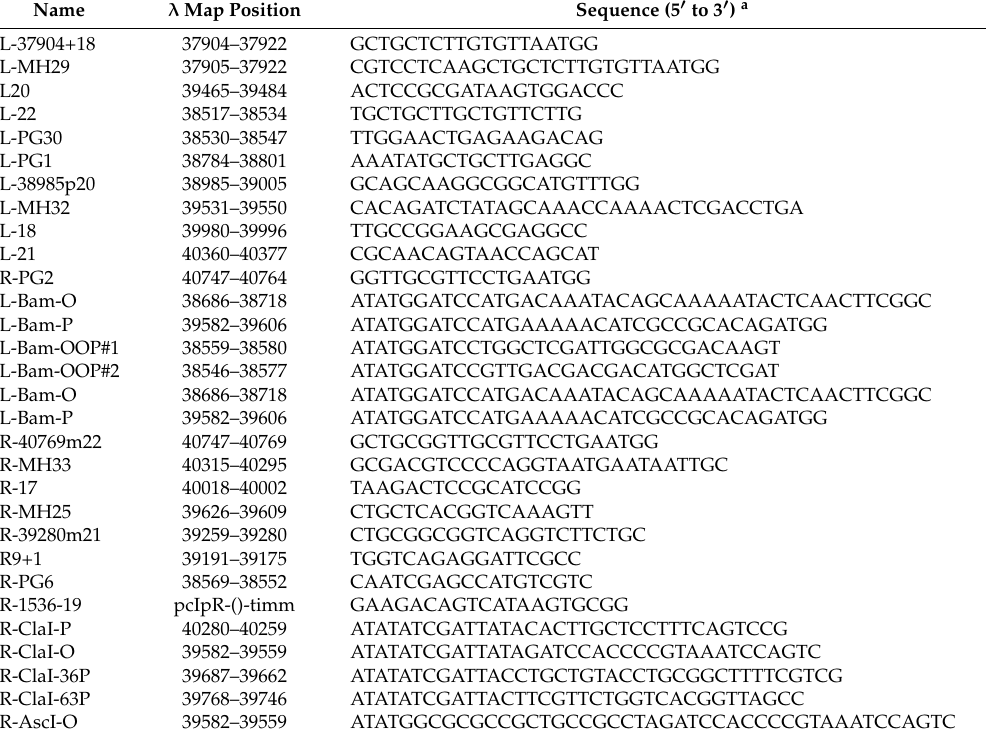
Table 4. Oligonucleotide primers employed for DNA sequence analysis and plasmid